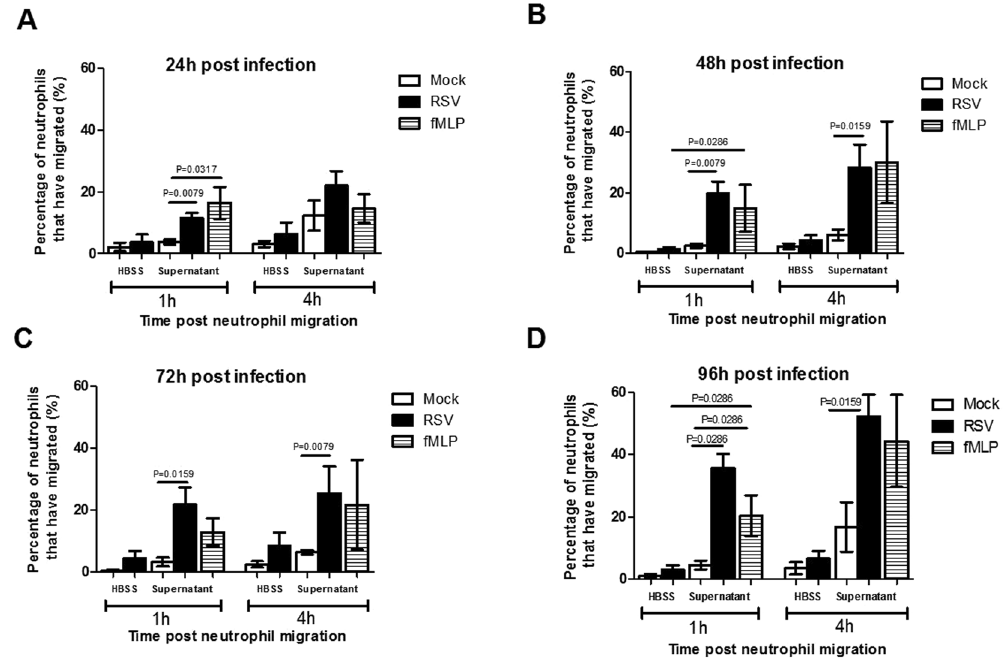
Figure 3. RSV increases the numbers of neutrophils that migrate through infected A549 monolayers The percentage of neutrophils that migrated through mock and RSV infected A549 monolayers after (A) 24 hours, (B) 48 h, (C) 72 h or (D) 96 hours post-infection was quantified. Neutrophils were exposed to infected A549 epithelial cells submerged in fresh HBSS + or the conditioned supernatant produced from the same cells prior to migration (RSV and mock infected). The neutrophil chemoattractant N-Formylmethionine-leucyl- phenylalanine (fMLP) was used as a positive control. Bars show mean ± SEM of n = 3/4 biological repeats. Statistical significance is shown. For all other comparisons P > 0.05.